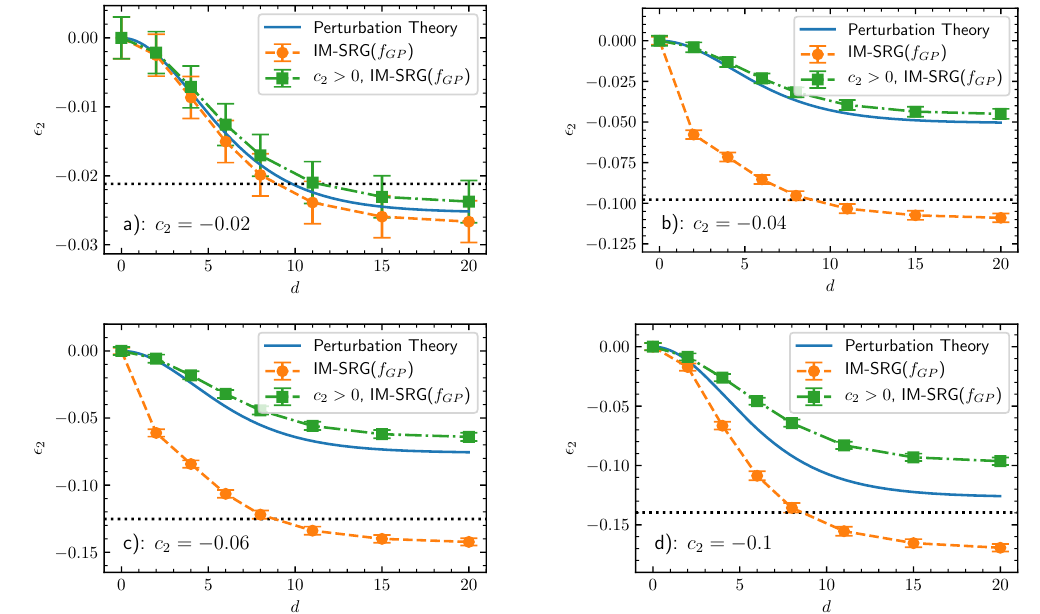
Figure 10: Induced impurity-impurity interaction for a repulsive and an attractive < 0, N = 60, and γ = 0.02. The four panels are for different values of impurity, c 2 = − 0.02, b) c = − 0.04, c) c = − 0.06, and d) c = − 0.1. The circles with c : a) c 2 2 2 2 2 error bars show the result of the IM-SRG( f ) calculation. The solid curve gives the GP result of first-order perturbation theory. For comparison, we also show the IM-SRG > 0 (squares) times (-1). The dashed and dot-dashed curves are added result for c 2 to guide the eye while the dotted lines show the self-energies of a single impurity, ( c = 0, c ) − E ( c = 0, c = 0 ) E 2 1 2 2 1 2